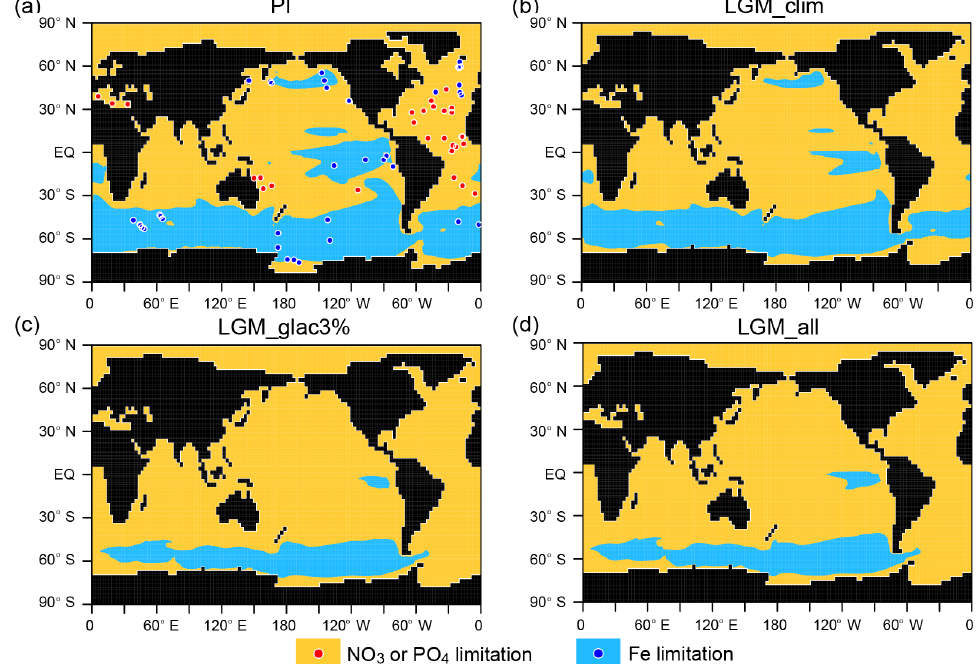
Figure 1. Primary limiting nutrient for phytoplankton for the (a) PI, (b) LGM_clim, (c) LGM_glac3%, and (d) LGM_all. Shade indicates NO 3 or PO 4 limitation (orange) and Fe limitation (blue). Circles represent observed limiting nutrients from nutrient addition experiments (Moore et al.,